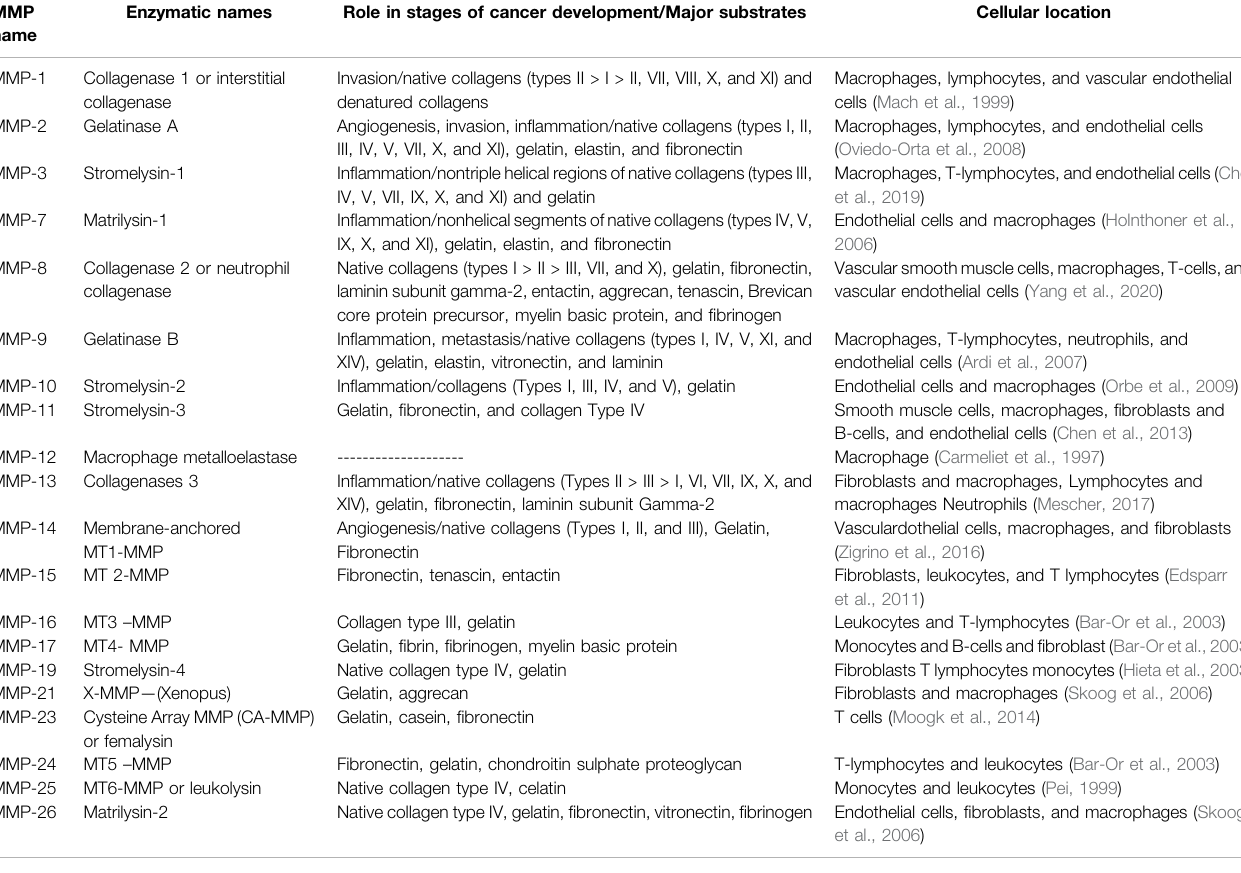
TABLE 1 | List of matrix metalloproteinases (MMPs), their enzymatic names, major substrates, and cellular location.